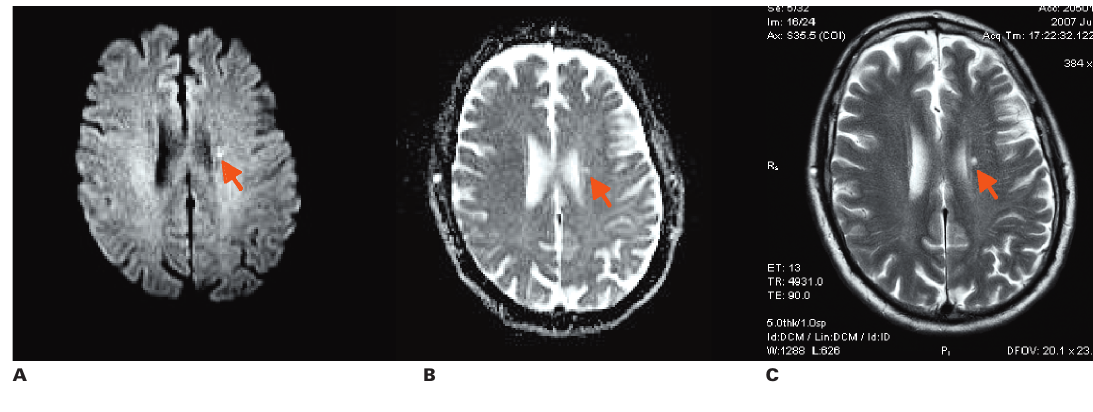
“T2-shine-through effect”. On the DW-image (A) a tiny ‘bright’ lesion (red arrow) suggested acute ischaemia. However, the bright appearance on the ADC map (B, red arrow) clarified that this lesion is weeks old. The lesion appearance being still “bright” on the DW-image (A) is explained by the fact, that signal intensity on DW-images reflects not only diffusion charac- teristics but also T2 properties of tissue. On the T2-weighted image (C, red arrow) the lesion also appears “bright”. The contri- bution of increasing T2-signal on the signal intensity on DW-images has been termed “T2-shine through” effect [71, 72].